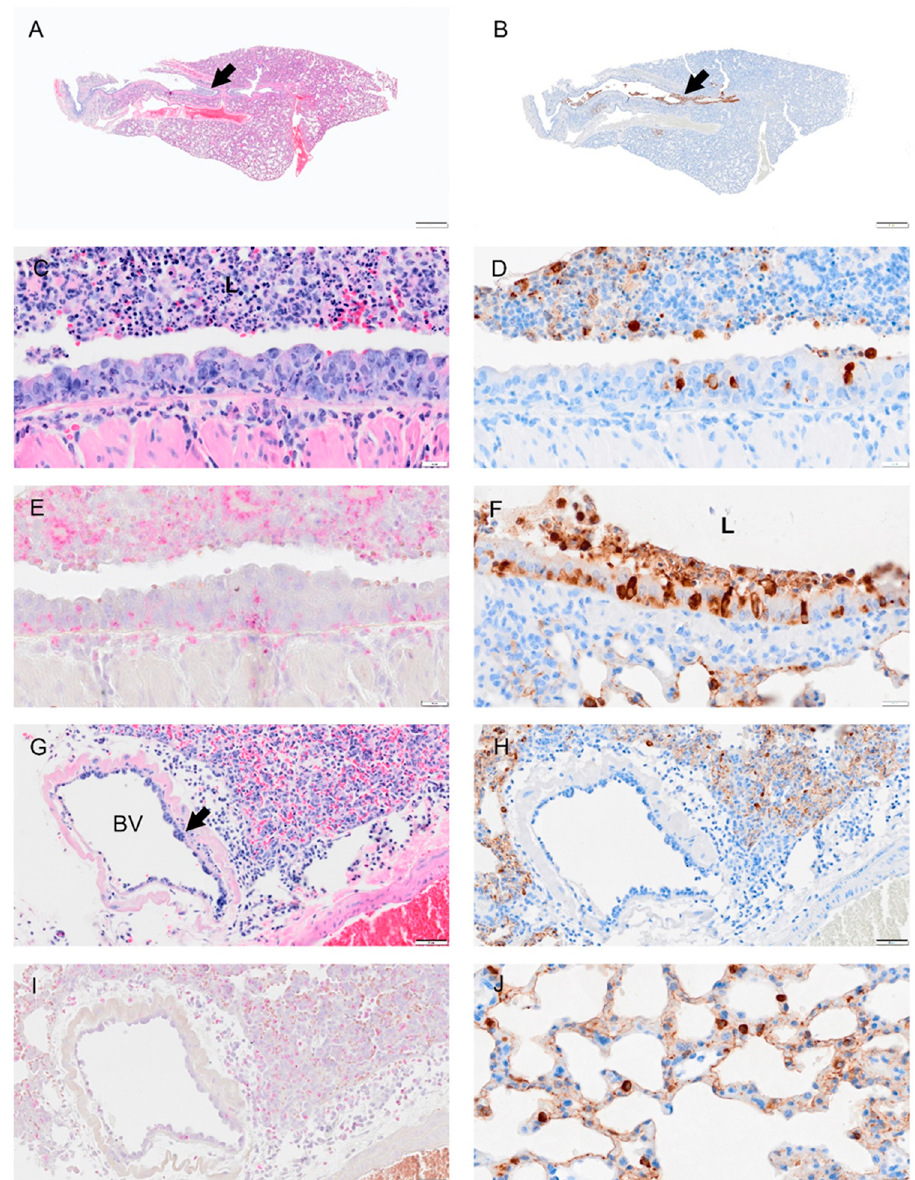
Figure 5. Selected pathology and immunohistochemistry of lungs from Syrian hamsters at 2 dpi with SARS-CoV-2. ( A ) A low magnification image shows widespread septal thickening and debris in the primary bronchial lumen (arrow). ( B ) Image of serial section adjacent to ( A ) showing viral antigen bronchial epithelium and debris. ( C ) Section showing the bronchus with abundant cell debris (neutrophils, monocytes, necrotic epithelial cells, pyknosis and karyorrhexis, red blood cells) in the bronchial lumen (L). Image also shows damaged epithelial cells (loss of cilia, disruption of cell layer and inflammatory cells in mucosal and submucosal layer. ( D ) Serial section adjacent to ( C ) showing scattered viral antigen positive cells in the epithelial layer and in lumenal debris. ( E ) NACE staining of bronchus which shows many infiltrating neutrophils. ( F ) Viral antigen in the bronchus, debris of lumen (L) and type 2 alveolar cells. ( G ) A blood vessel (BV) showed thickened hypercellular endothelium(arrow) and inflammatory cell infiltrates in the vascular tunica media, interstitium, and alveoli. ( H ) Serial section adjacent to ( G ) shows viral antigen in the alveolar cells but not in the blood vessel. ( I ) NACE staining of the blood vessel and surrounding tissues showing neutrophil infiltration. ( J ) Section shows viral antigen in type 2 alveolar cells and thickened septa. Bar: ( A , B ) = 1 mm; ( C – F ) = 20 µ m; ( G – I ) = 50 µ m and ( J ) = 20 µ